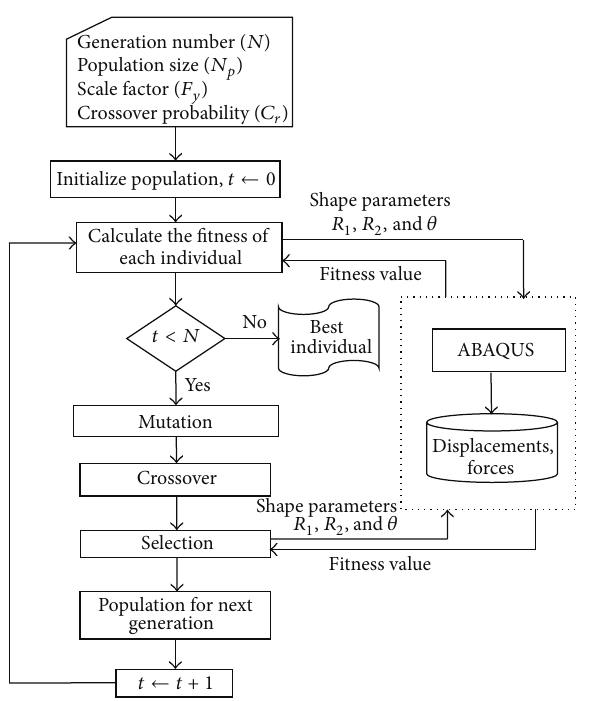
Figure 9: The flowchart of the proposed methodology and Abaqus